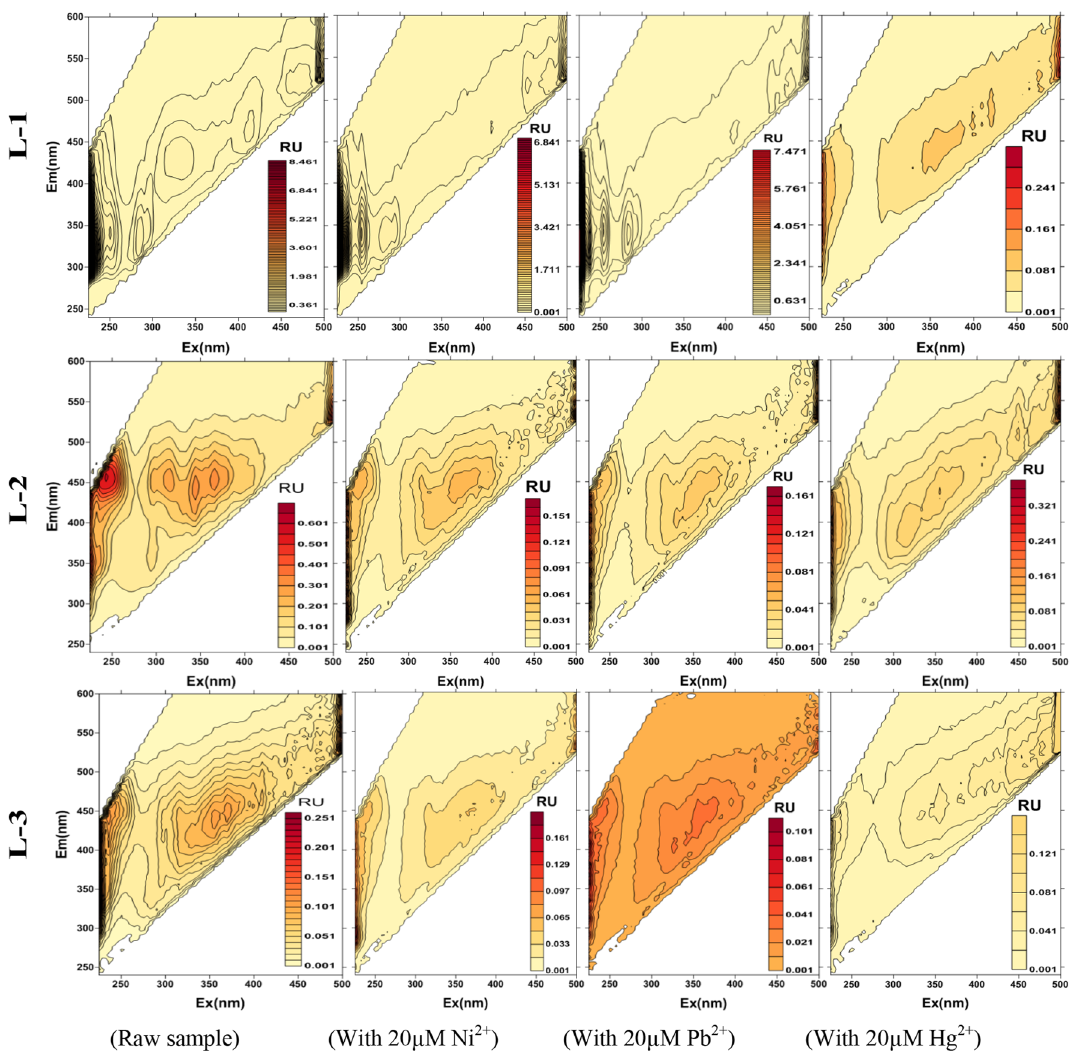
Fig. 2 Comparison of EEM spectra of L-1, L-2 and L-3 before and after complexation titrations Table 2 DOM-Ni 2+ , DOM-Pb 2+ and DOM-Hg 2+ binding